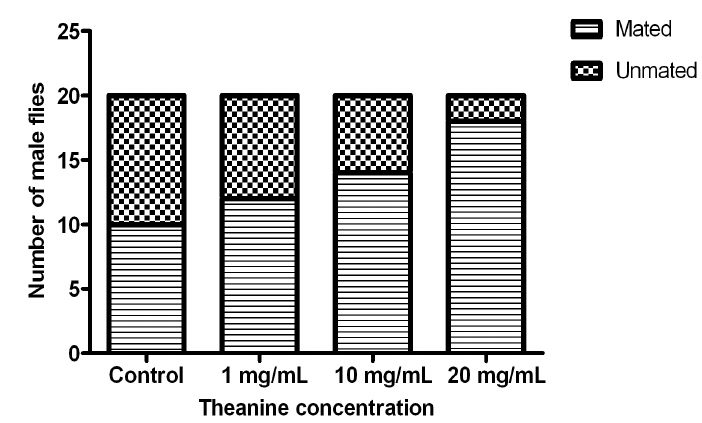
Figure 3. L -theanine treatment improves courting ability of Drosophila males. Proportion of mated males within two h in the group was steadily increased with theanine concentration. Statistical analysis was performed with chi-square trend test, p <